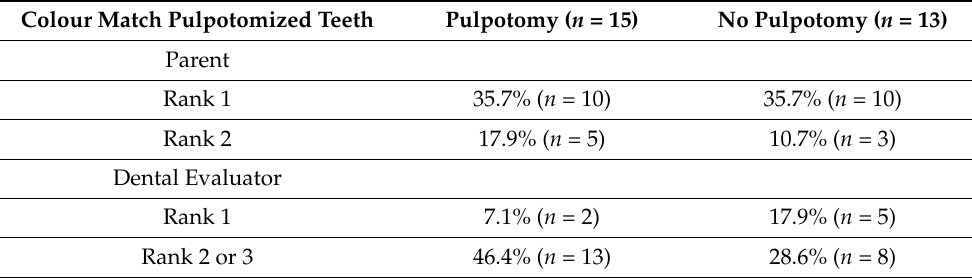
Table 6. Colour match ranking by parent or dental evaluator for pulpotomized